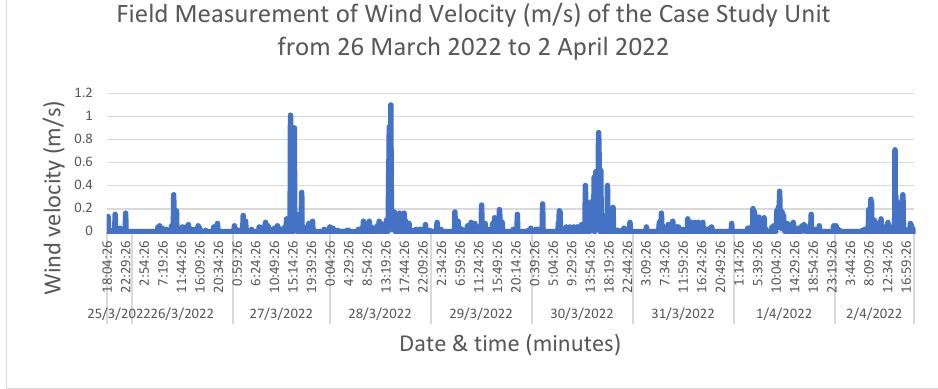
Figure 7. Field measurement results of the indoor wind velocity (m/s), taken at 5-minute intervals.